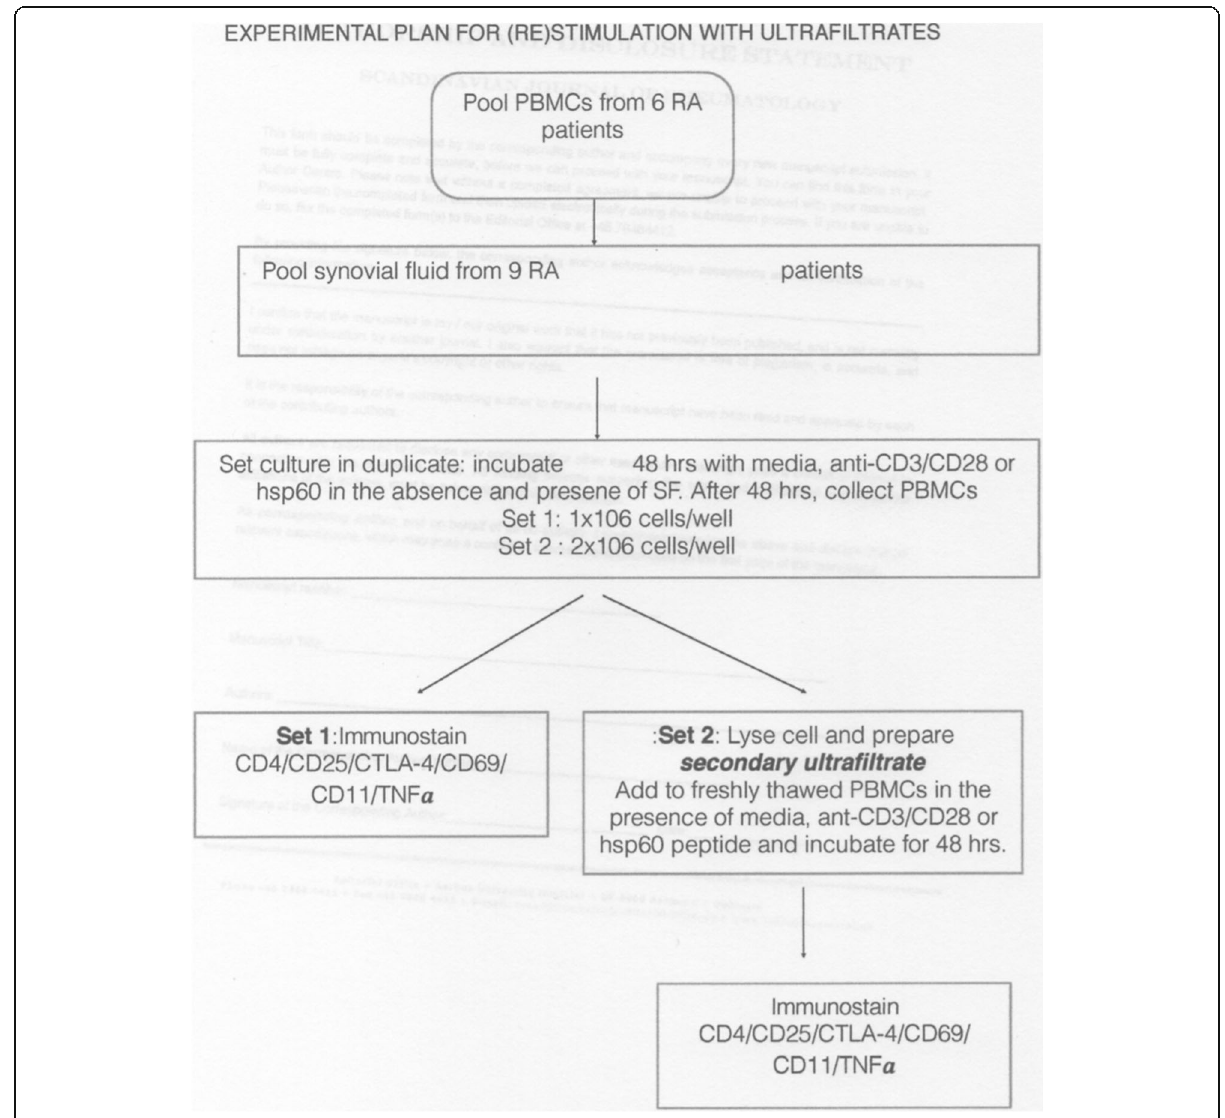
Fig. 1 Experimental plan for (re)stimulation with